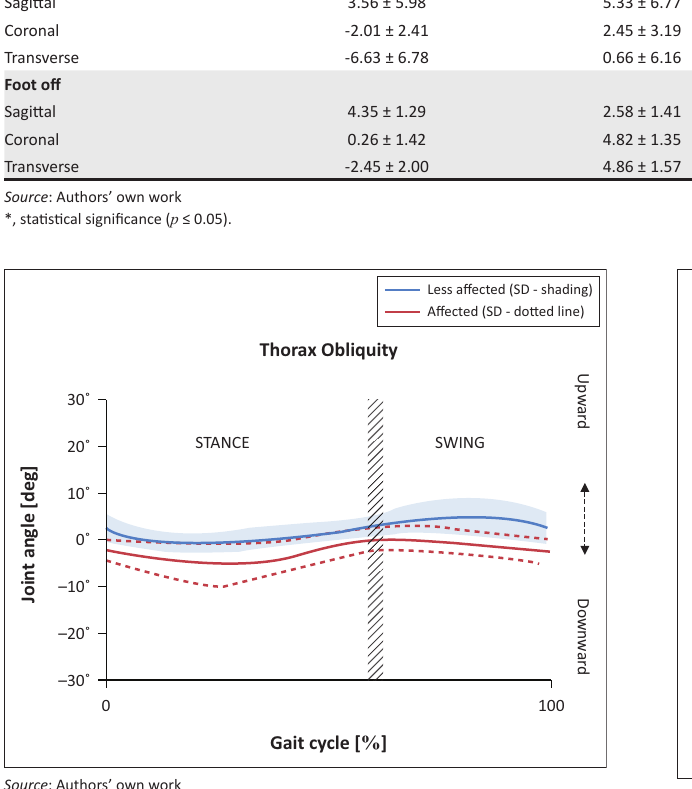
FIGURE 2: Trunk kinematics in the coronal plane affected versus unaffected.